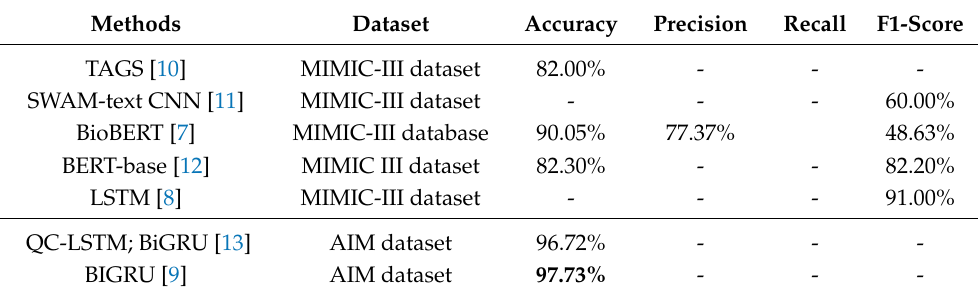
Table 5. Performance of the most frequent text classification methods and database